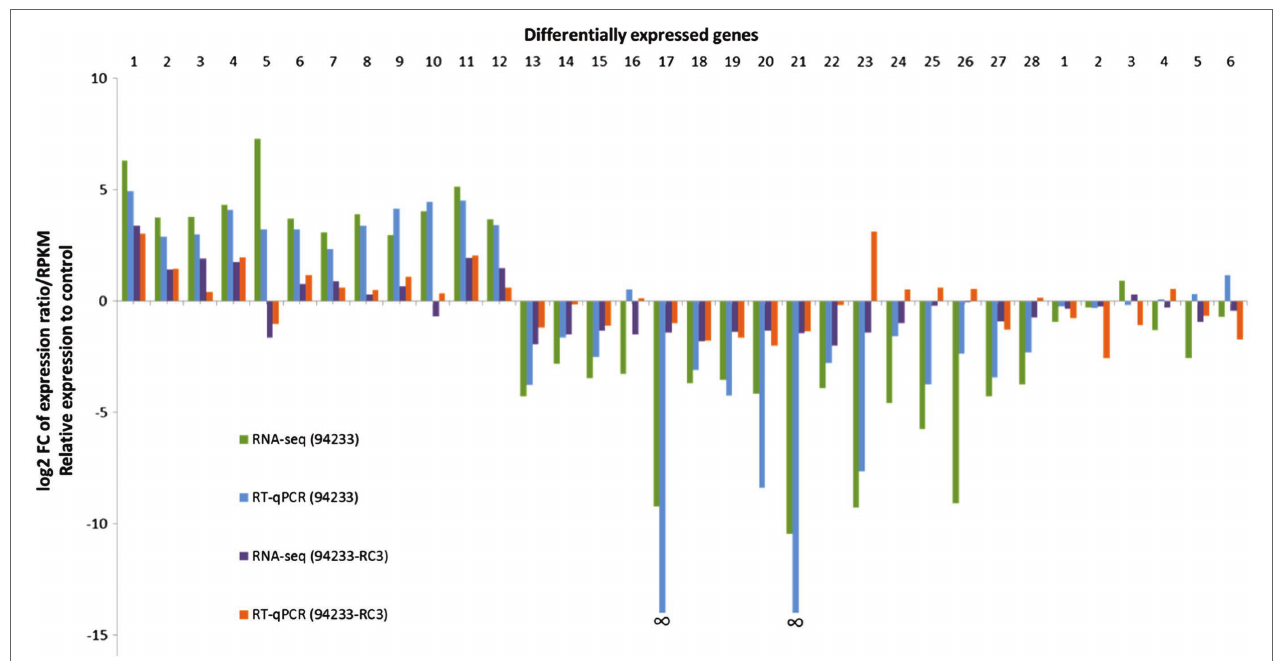
FIGURE 3 | 94233-RC3-transcriptome RNA-seq data and qPCR validation. The columns relate to fold changes in gene expression of HetPV13-an1 hosting H. annosum strains 94233 and 94233-RC3, each was compared to the HetPV13-an1-free control 94233-32D. Names and gene id numbers of the 28 and then 6 RNAi-related target genes are listed ( Supplementary Table S2 ). The relative expression of RNA-Seq corresponds to log 2 fold change of reads per kb of transcript per million mapped reads (RPKM). The data for HetRV3-an1 (94233) are taken from Vainio et al.